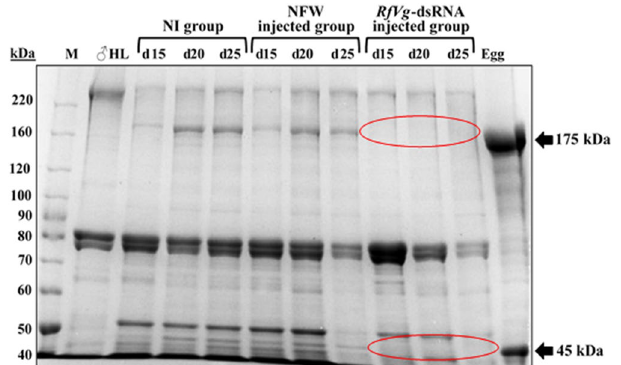
Figure 4. Validation of RNAi and expression analysis of RfVgs by SDS-PAGE. To clarify the RfVg protein expression, hemolymph samples (10 μl/lane) prepared from NI, NFW, and RfVg -dsRNA injected groups on 15, 20, and 25 days (d) post-injection periods were loaded on SDS-PAGE (8%) and compared. All biological groups contained three replicates; each replicate was an individual R. ferrugineus , while there were three technical replicates. The gel was stained with Coomassie blue and washed with destaining solution. M is the molecular marker (kDa) while, arrows on right side indicate the identified Vg polypeptides (175 and 45 kDa) in R. ferrugineus . A highly downregulated expression of Vg protein in RfVg -dsRNA injected group as compared to NI and NFW injected groups has been shown with the red circles. The protein bands were visualized under the white light and photographed by using gel documentation BioDocAnalyze system (Biometra). d